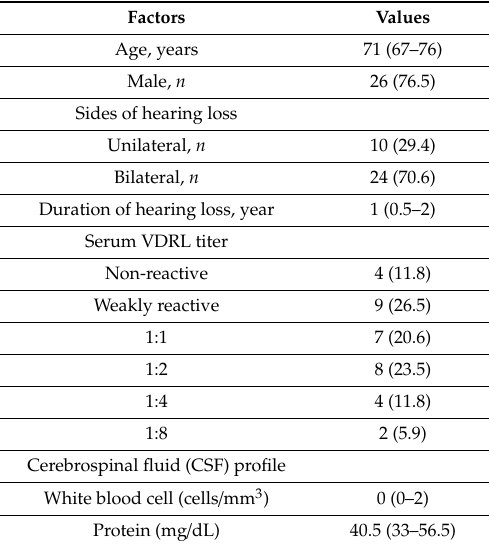
Table 1. Clinical features of the 34 patients with otosyphilis that were treated with penicillin G